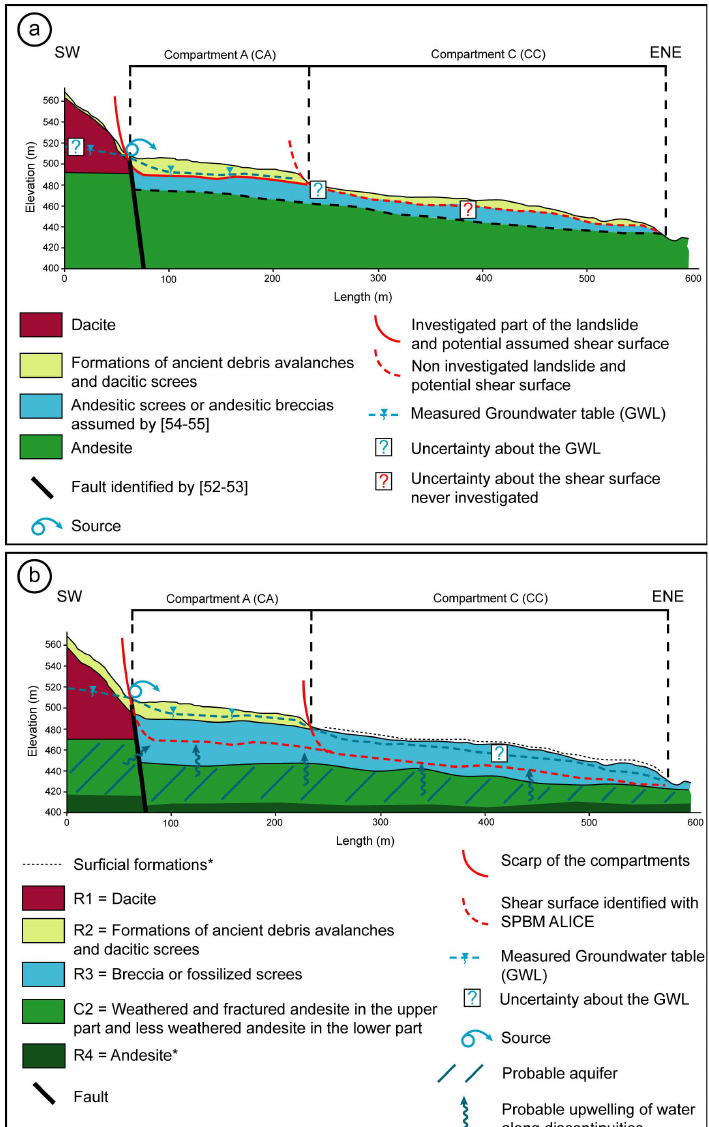
Figure 16. La M é daille conceptualization. ( a ) Before this study; ( b ) after this study (* data not used in the computations of failure probabilities with ALICE ®